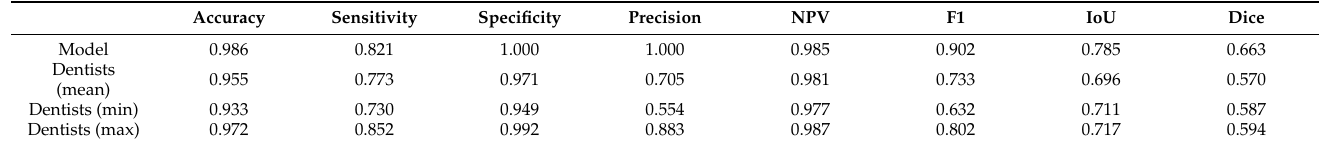
Table 3. Segmentation performances of nnU-Net and the dentists with the test set.